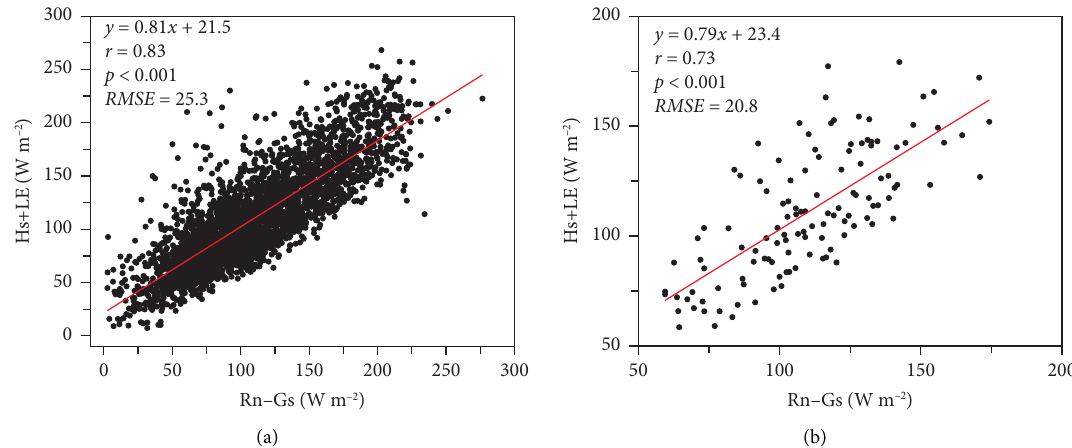
Figure 3: Relationship between the daily (a) and monthly (b) averaged turbulent energy fux (Hs + LE) and available energy fux (Rn − Gs) from 2007 to 2018.